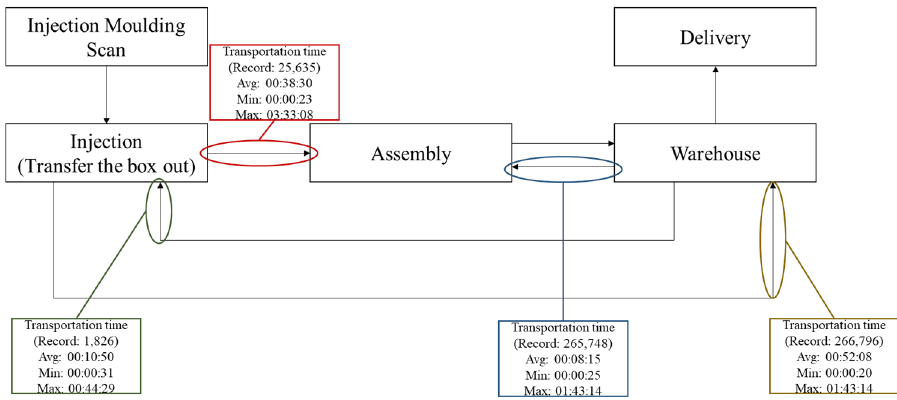
Figure 11. Transportation time for each in-house transit process after removing outliers.